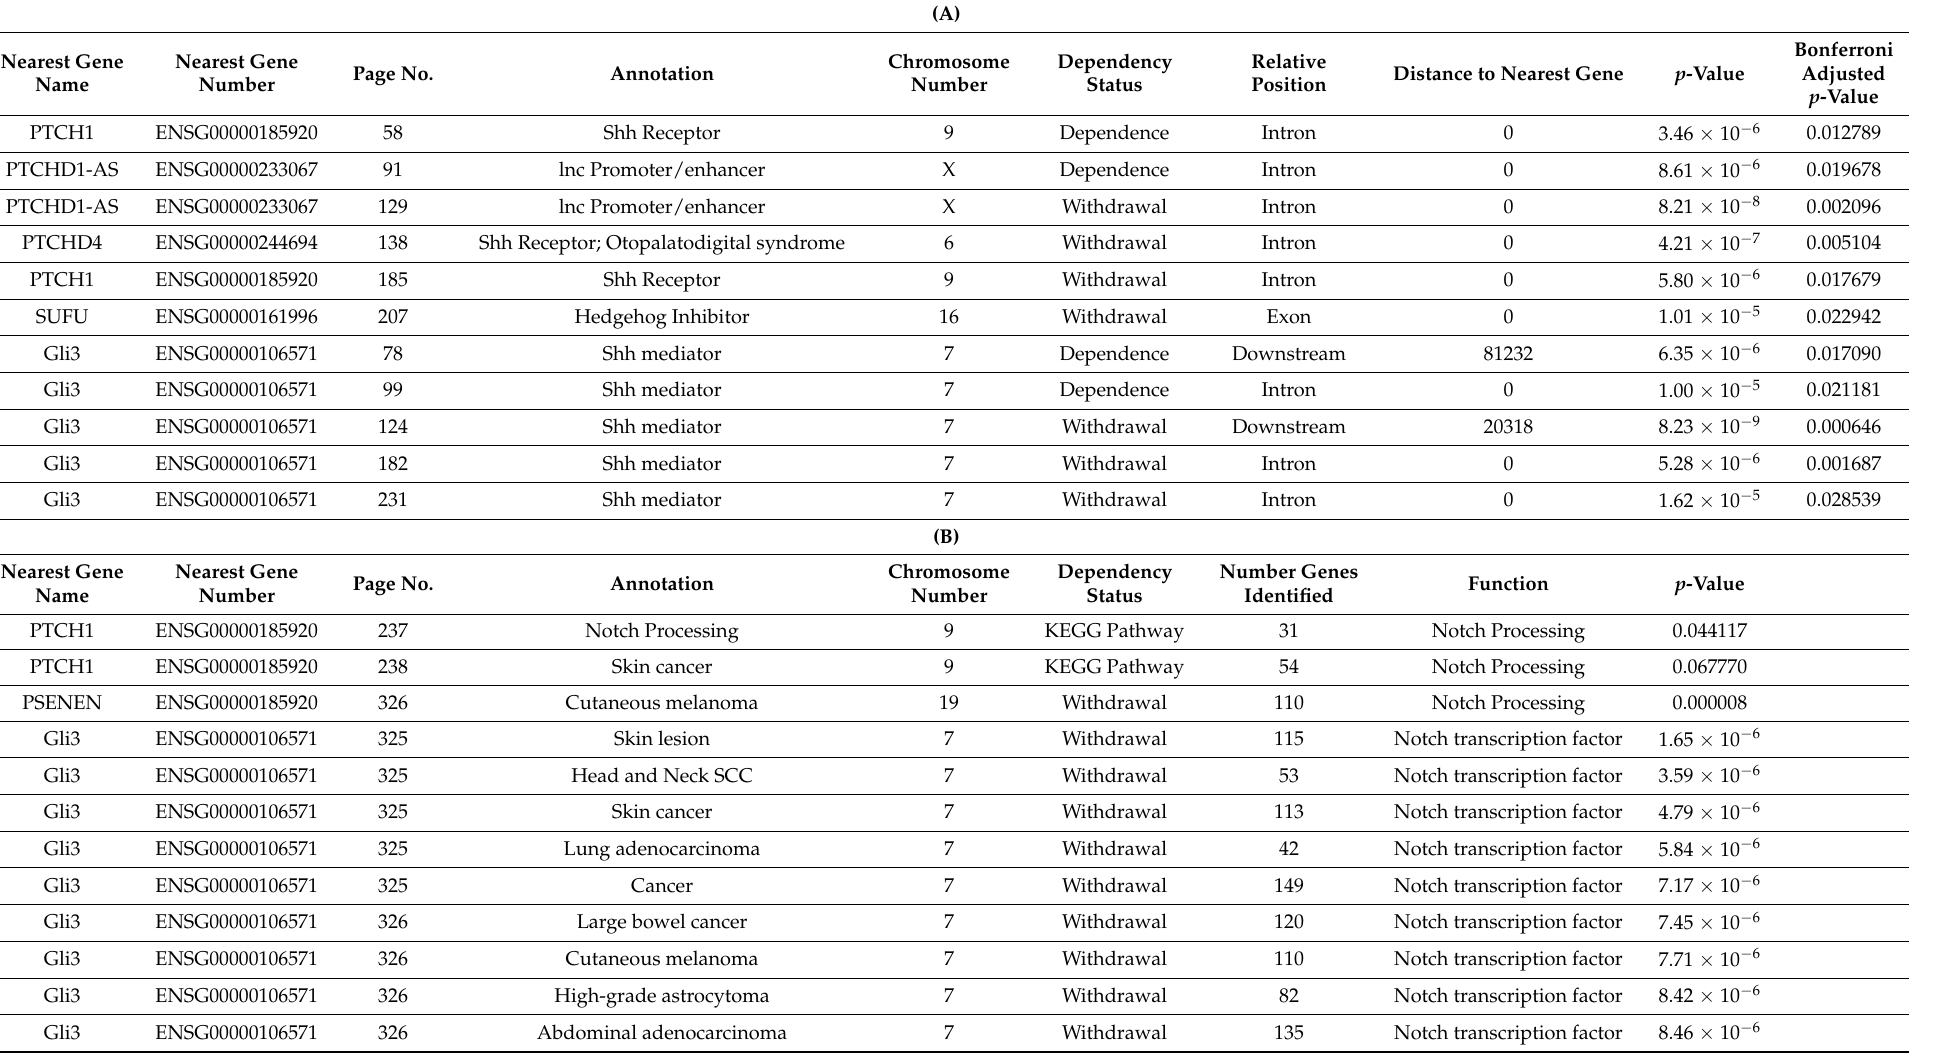
Table 5. Cannabis Impacts on Sonic Hedgehog Signaling, Schrott EWAS Data.